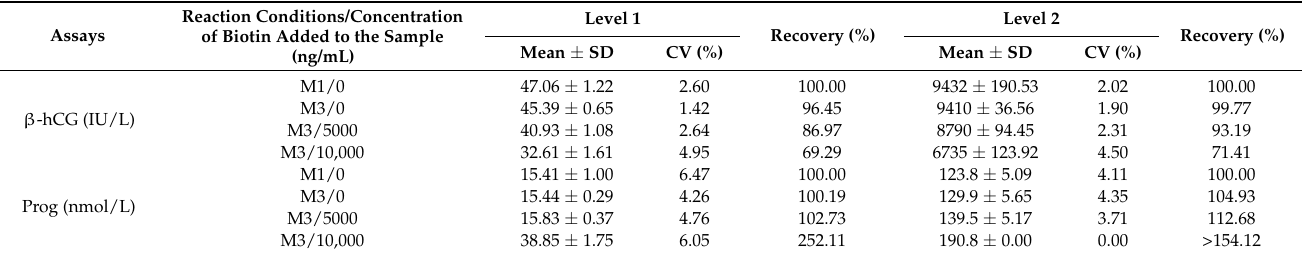
Table 2. Precision and